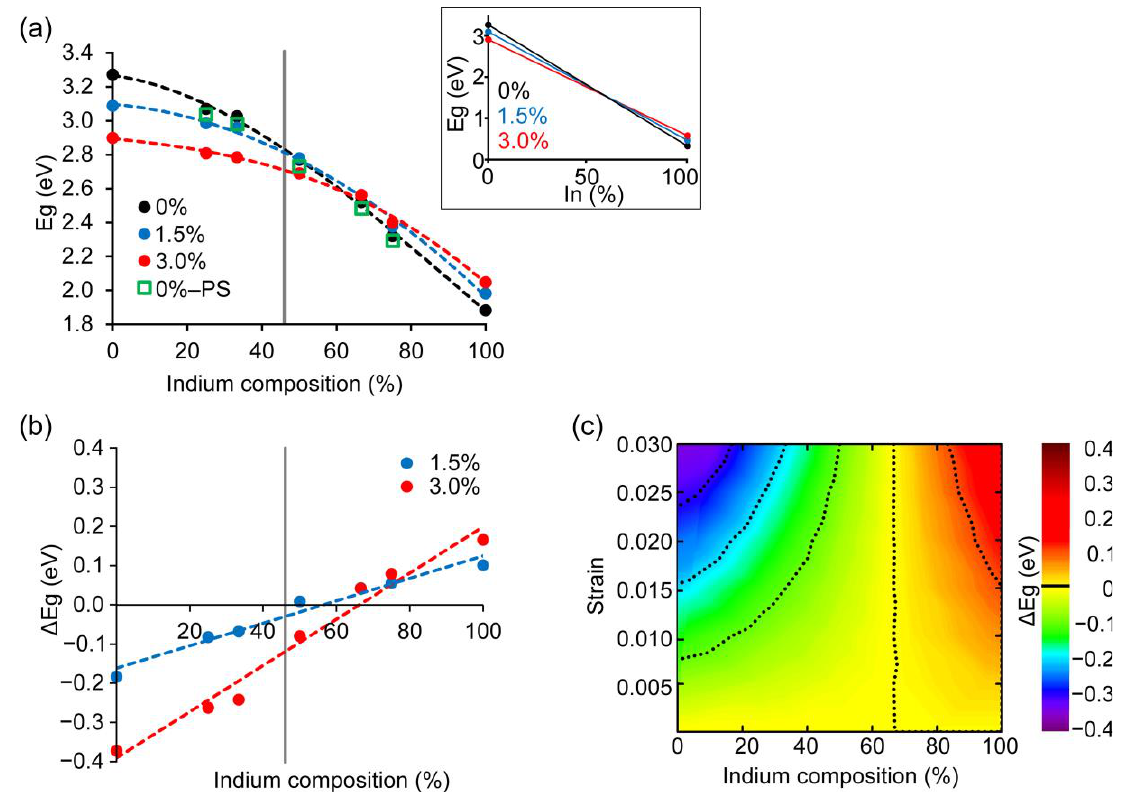
Figure 4. ( a ) Diagram of band - gap energy of short - period superlattice with respect to the indium content of its quantum wells. Vertical gray line indicates the highest indium content experimentally achieved so far. PS indicates heterostructures with phase - separated quantum wells. Inset illustrates band gaps of bulk GaN, relaxed and equibiaxially strained on the basal plane, and of bulk InN when pseudomorphic to relaxed or strained GaN. ( b ) Diagram of band - gap energy change Δ E g with respect to relaxed GaN plotted against indium content. Change from negative to positive values is observed after 50–70% indium content. ( c ) Contour plot showing variation of Δ E g depending on composition of quantum well and strain in the barrier.